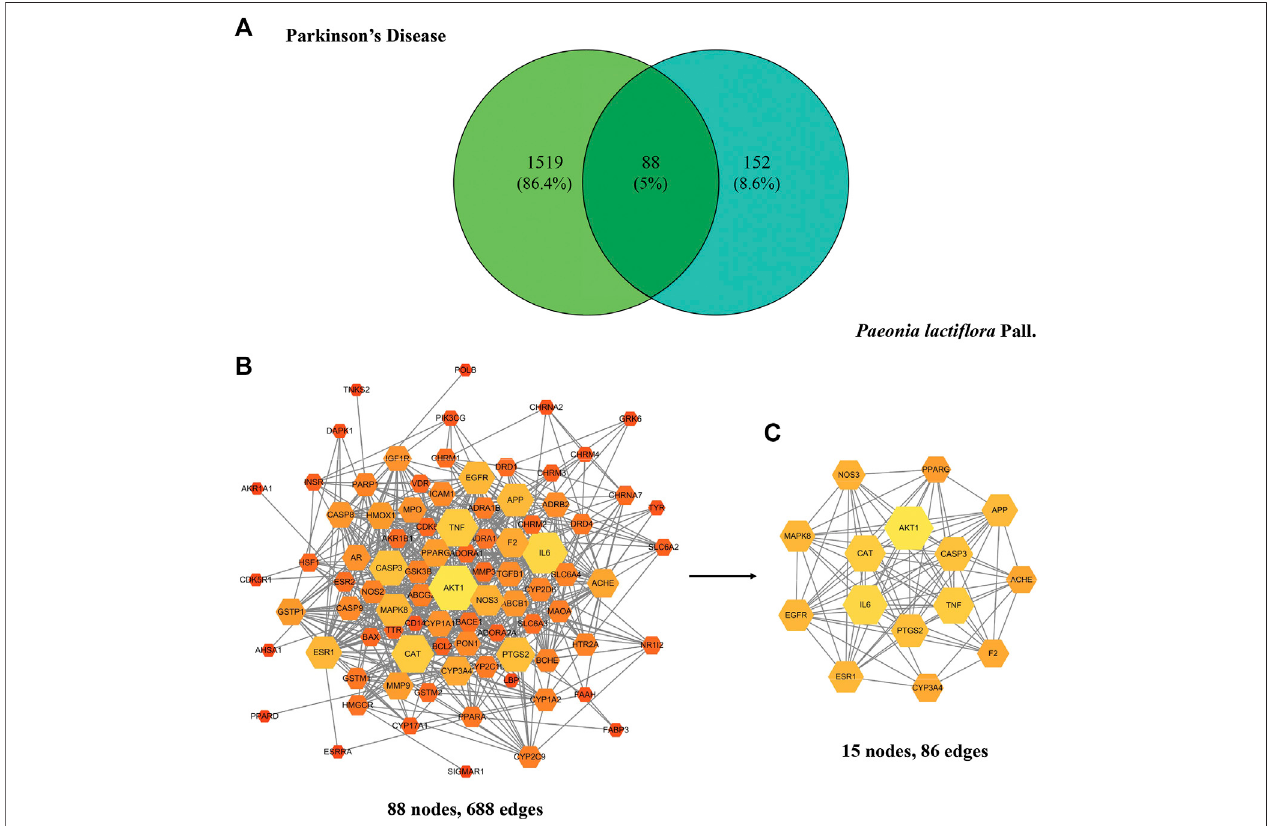
FIGURE 1 | (A) Common targets of Paeonia lacti fl ora Pall. and Parkinson ’ s disease. (B) Protein-Protein-Interaction (PPI) network of putative targets. (C) PPI core network. The size and color of the node represent its Degree. Degree equals the number of nodes connected by a node. The larger and brighter the node is, the more important it is in the